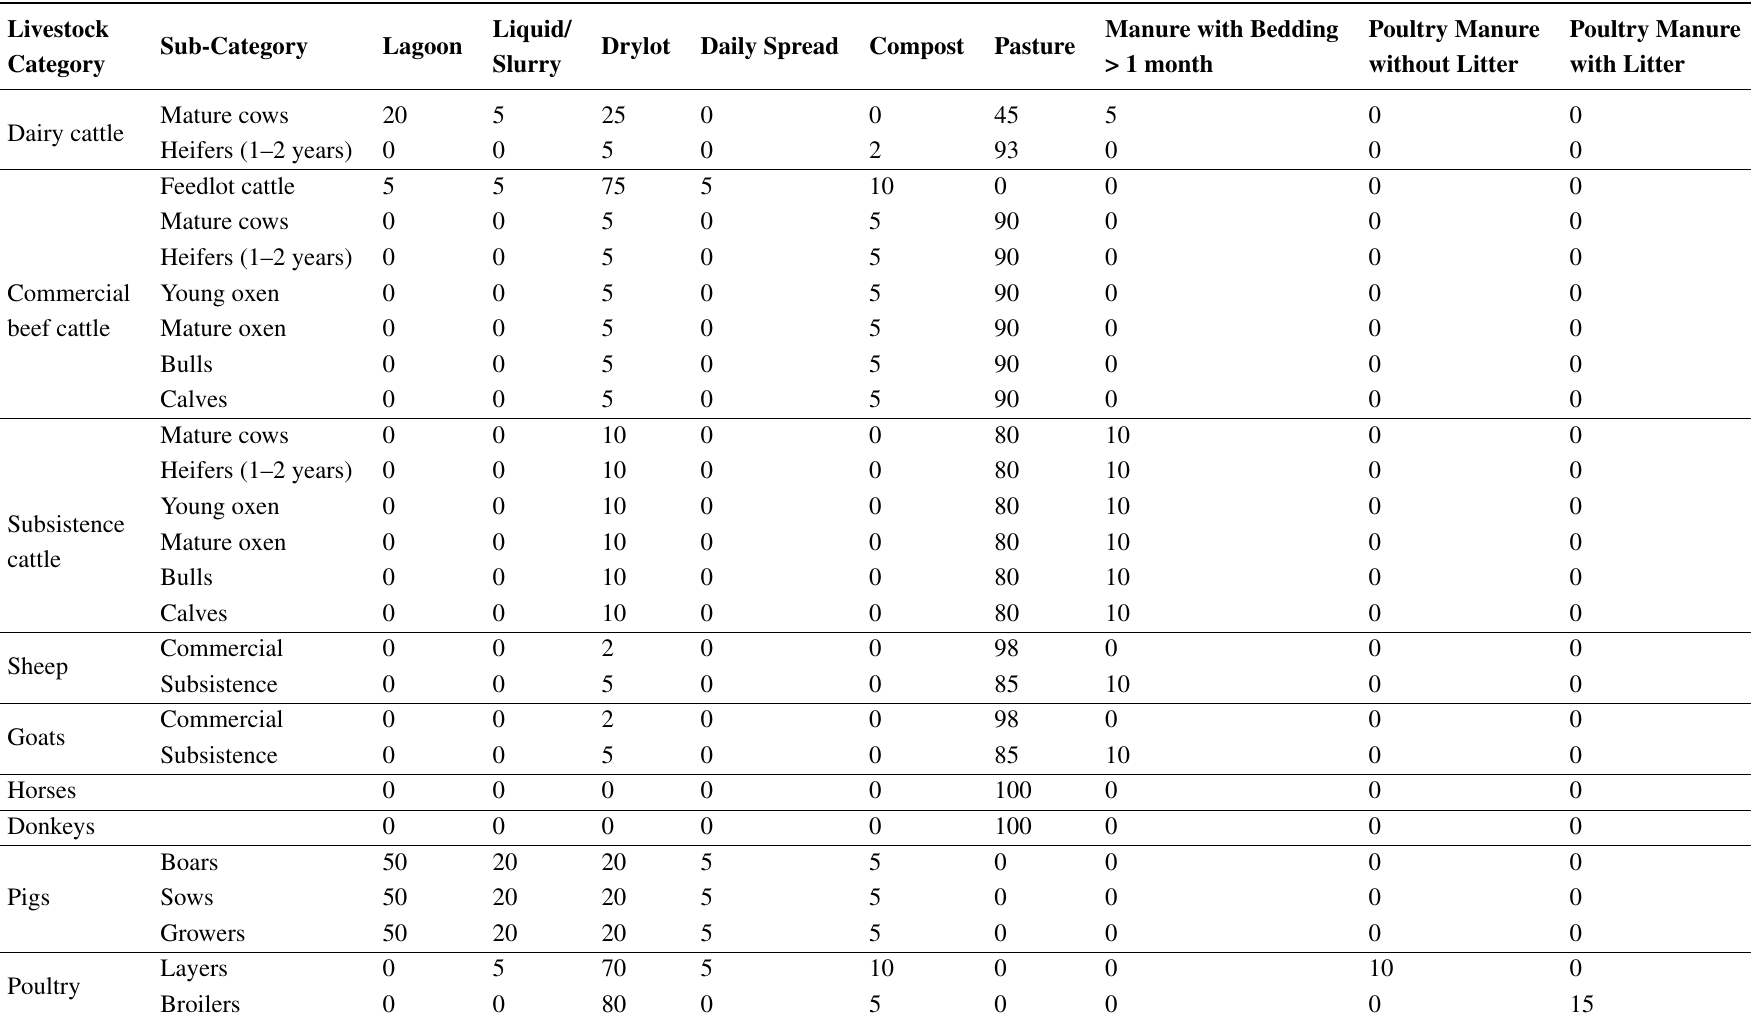
Table 1. Manure management system usage (%) for different livestock